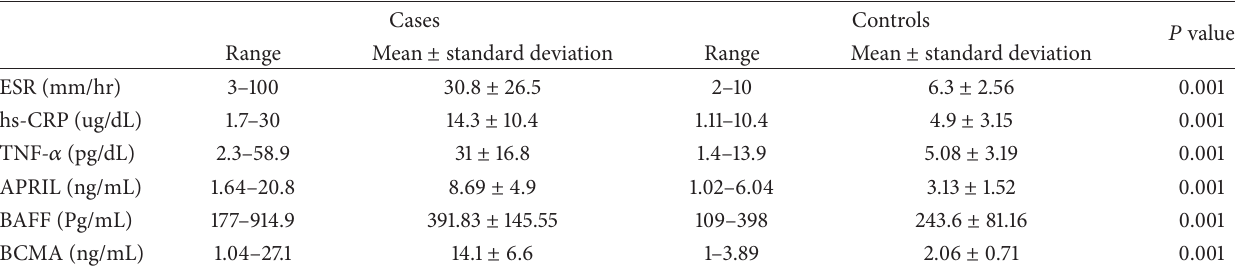
Table 2: Laboratory data of patients and controls.